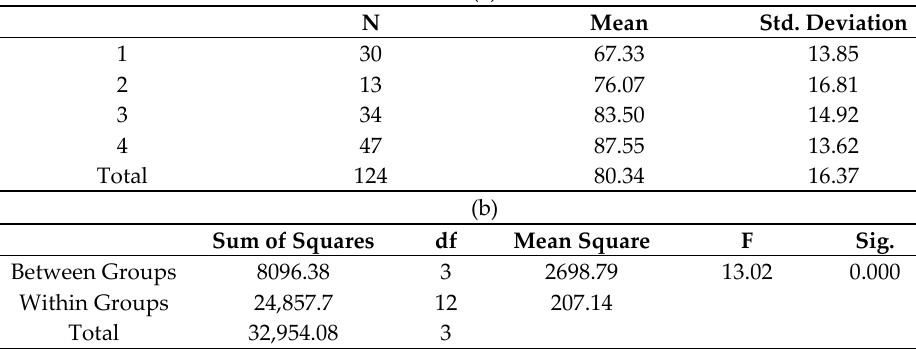
Table 3. Year of Study and IRMA: ANOVA.